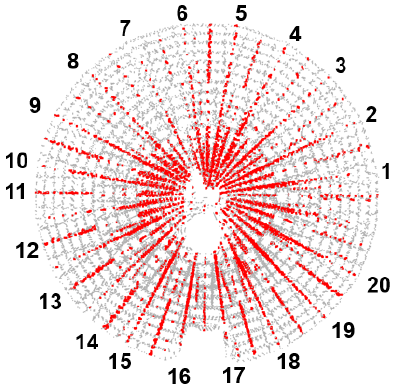
Figure 42. Extracted stringer features and the corresponding feature IDs for the West Lafayette da- taset.